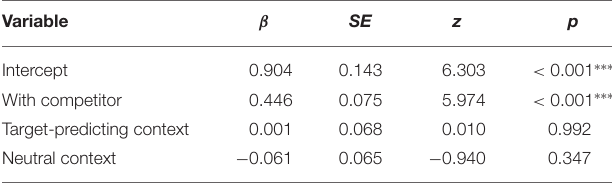
TABLE 7 | Regression coefficients of the logistic linear mixed effects model including the responses from the first half of Experiment 2.